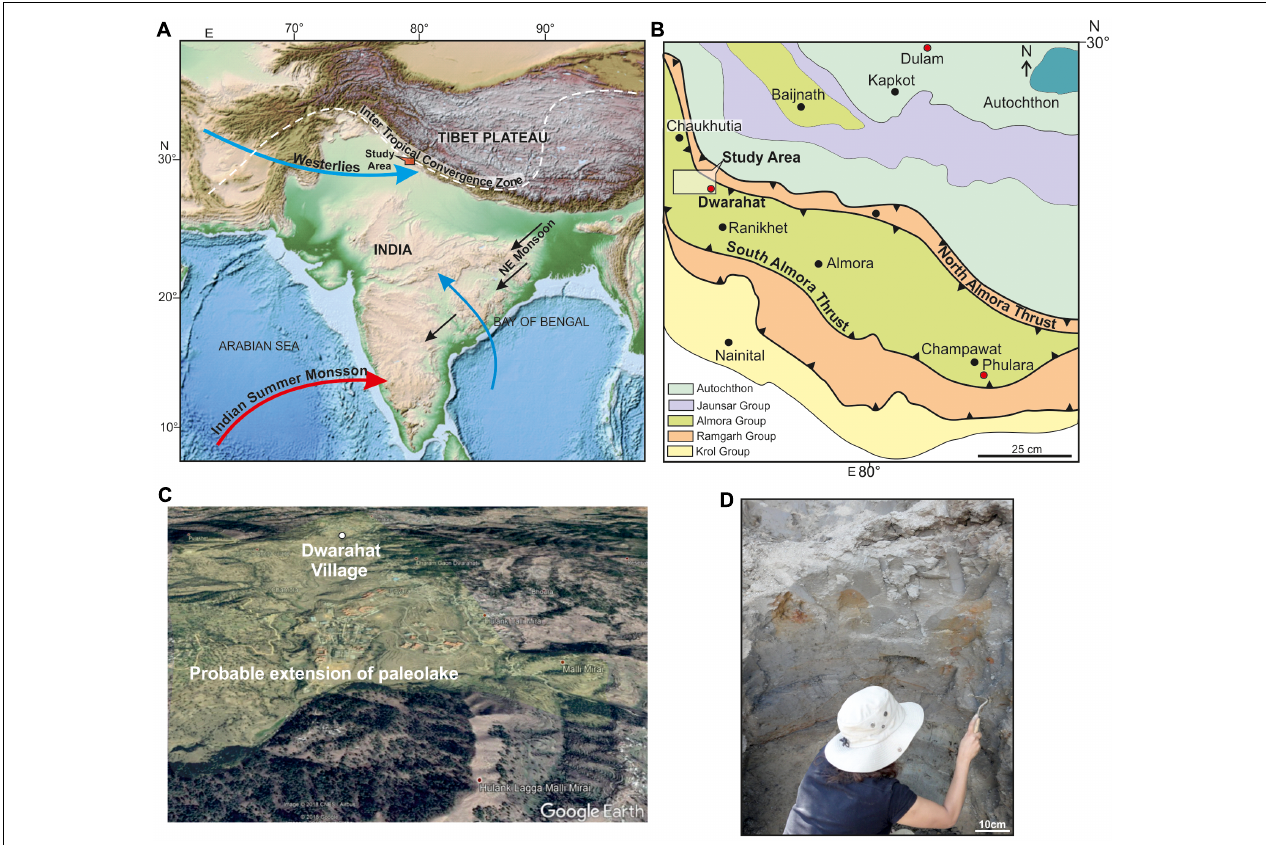
FIGURE 1 | (A) Map shows the location of study area (Dwarahat paleolake) with trend of monsoon systems (ISM, EASM, and WDs), source of the base map: Amante and Eakins (2009), http://www.ngdc.noaa.gov/mgg/image/color_etopo1_ice_low.jpg. (B) Geology and tectonics around the study area (modified after, Joshi, 1999). (C) Google image of the Dwarahat paleolake and (D) a field exposure of paleo-lacustrine deposit.